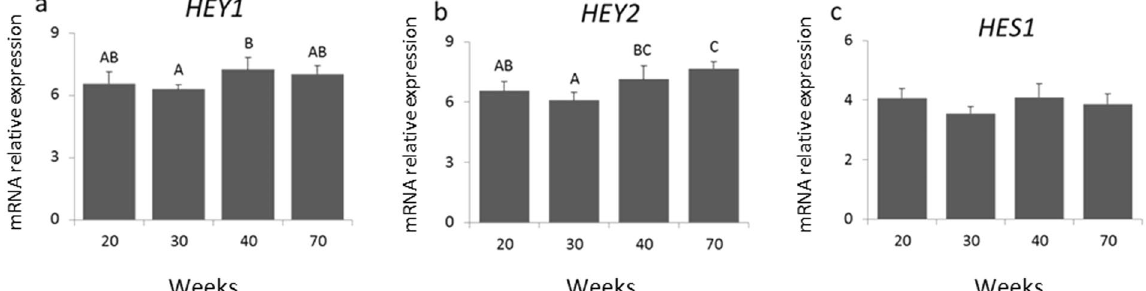
Figure 4. Differential gene expression of Notch target genes HEY1, HEY2 and HES1 , normalized to GAPDH , were determined by qRT-PCR in mammary biopsies from heifers aged 20, 30, 40 and 70 weeks (n = 4, 10, 7, 9 ( a) ); (n = 3, 8, 7, 8 (b) ); (n = 3, 9, 7, 10 (c) ). Different letters indicate significant differences (p ≤ 0.05) between ages.